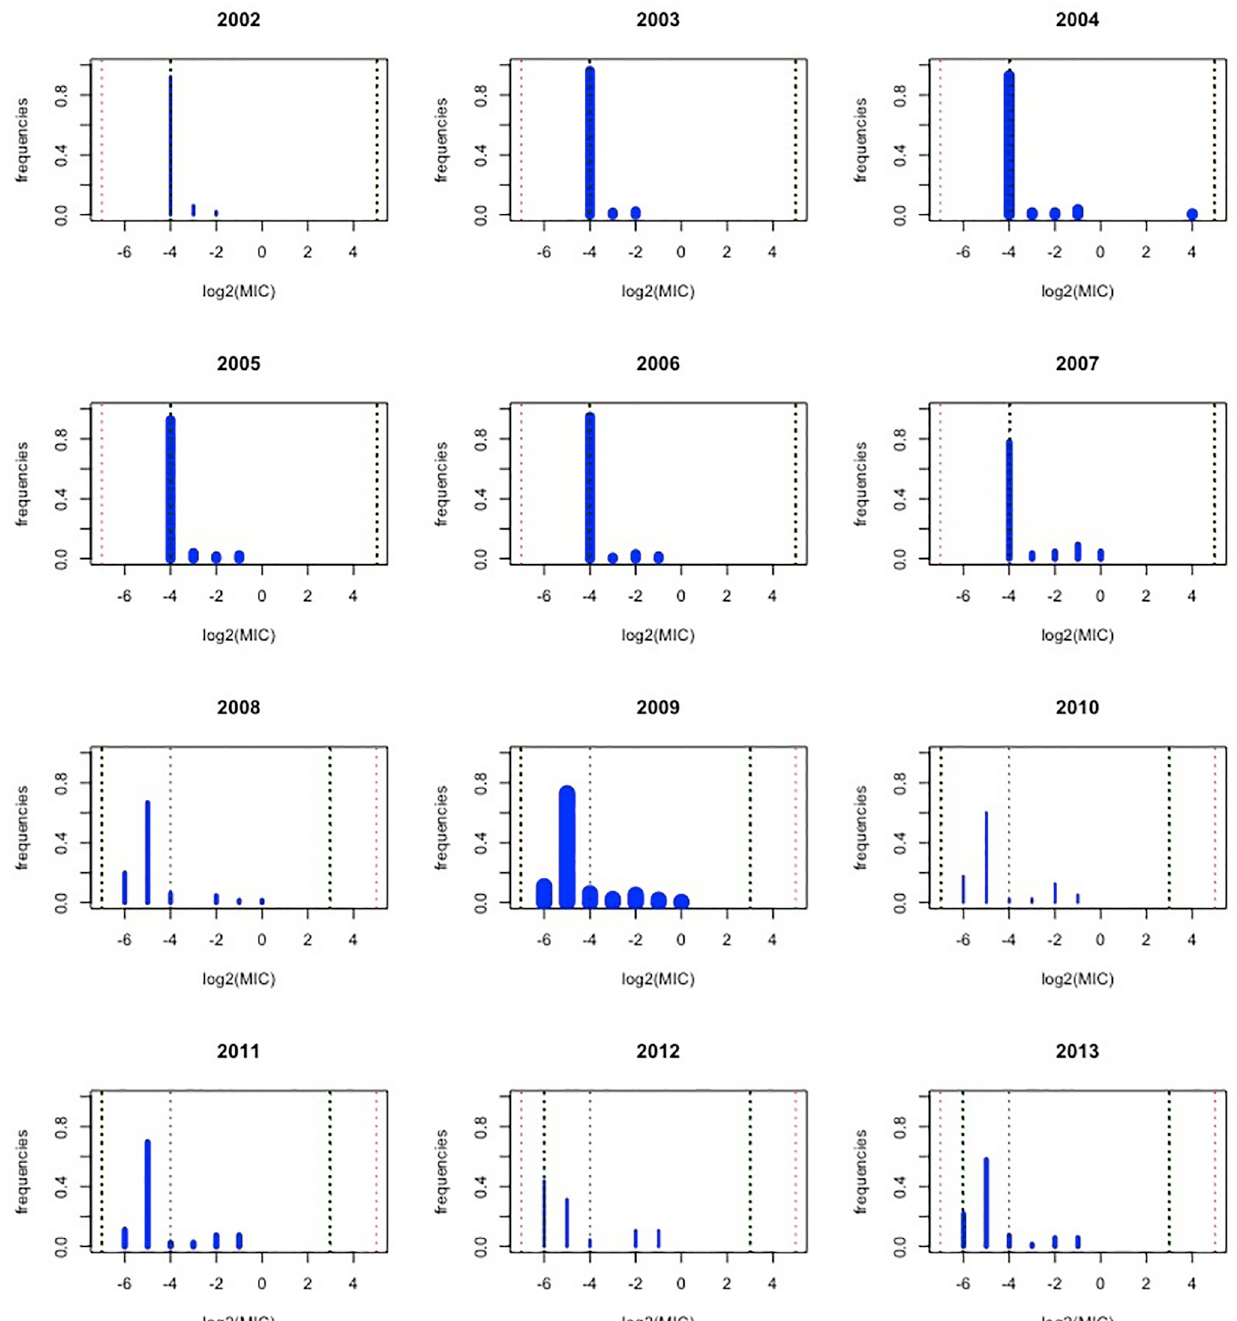
Fig 3. Barplots of the CIPR data. Barplots with observed relative frequencies for each year in the period 2002–2013, with barwidth proportional to the sample size of the respective year. The dotted vertical lines indicate: the smallest lower bound -7 and the highest upper bound 5 across all years (in red); the lower and upper bound of the experiments of the corresponding year (in green), the ECOFF (in black).